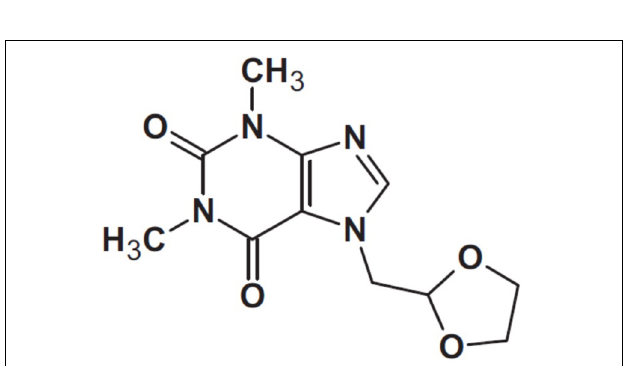
FIGURE 3 | Doxofylline